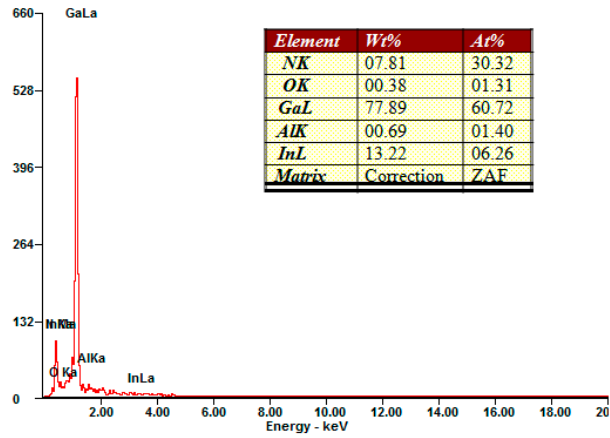
Figure 8. Energy Dispersive X-ray (EDX) of GaN based laser diode surface.